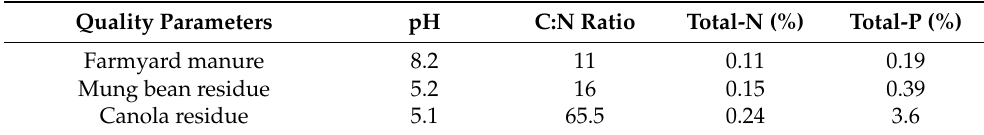
Table 1. Some quality parameters of the organic materials used in the